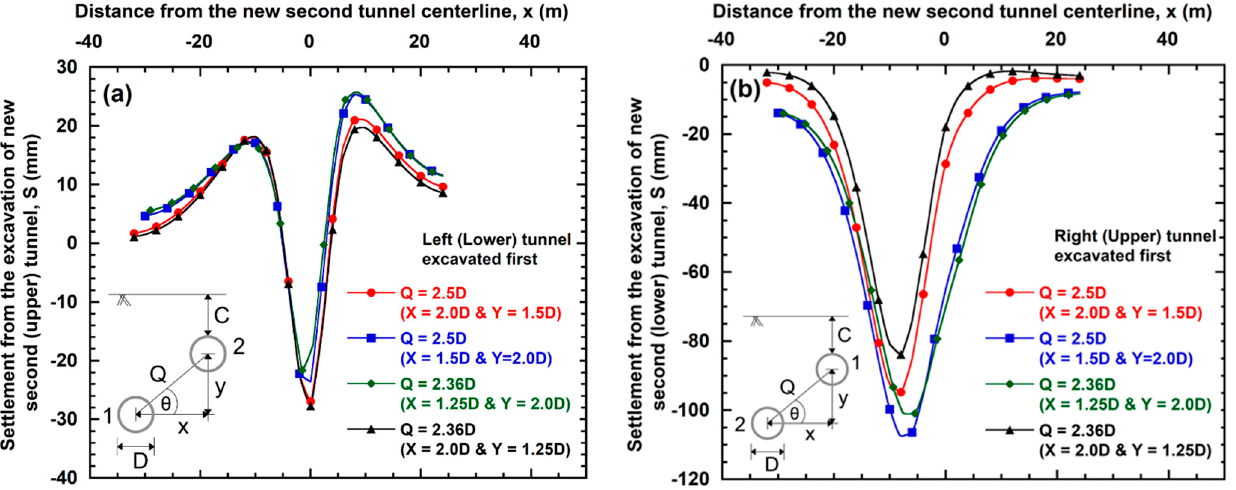
Figure 13. Effect of the horizontal and vertical spacing on surface vertical settlement above the new second tunnel in the presence of an existing tunnel at a fixed angular spacing ( a,b ).